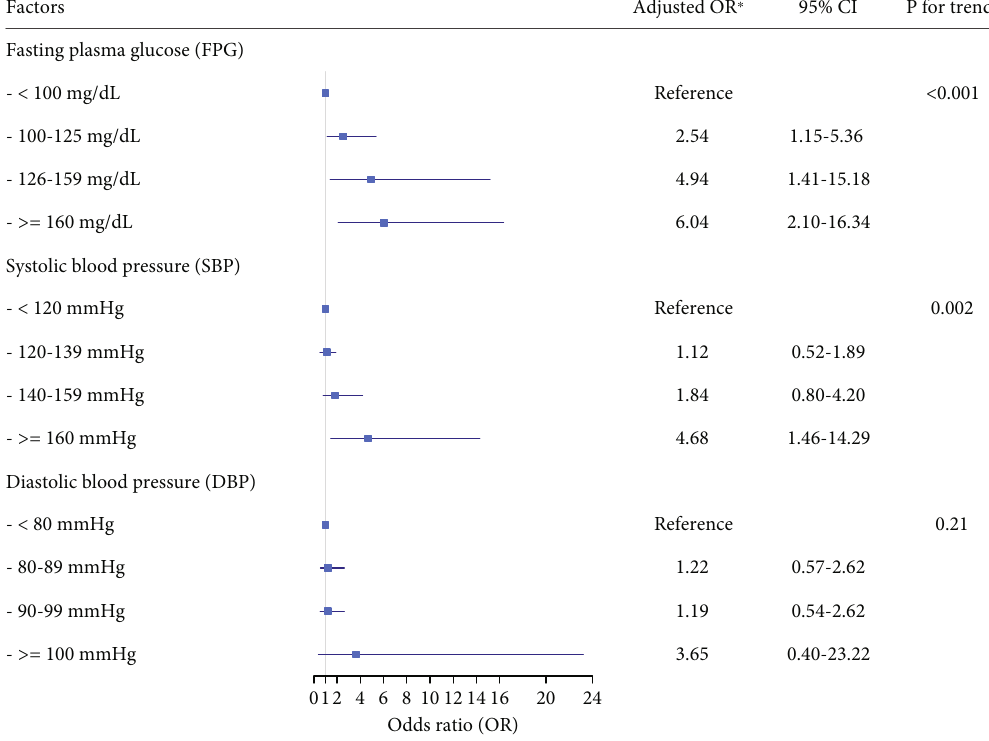
Figure 1: Associations of fasting plasma glucose (FPG), systolic blood pressure (SBP), and diastolic blood pressure (DBP) after subgroup categorization for the severity with all-cause mortality during the 10-year follow-up. ∗ Model consisted of sex, age, BMI, eGFR, and TG at baseline. P value < 0.05 was considered statistically signi fi cant. OR: odds ratio; BMI: body mass index; eGFR: estimated glomerular fi ltration rate; TG: triglyceride; DM: diabetes mellitus; HT: